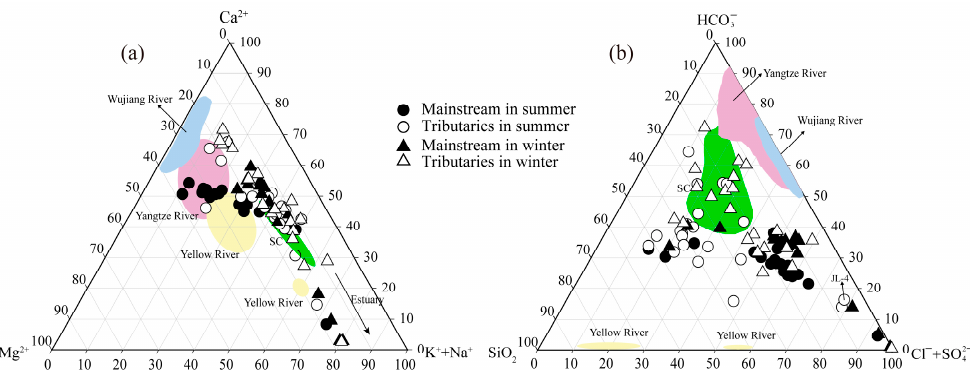
Figure 3. Ternary diagrams of ( a ) cations, ( b ) anions and dissolved silica in the JR. Some large